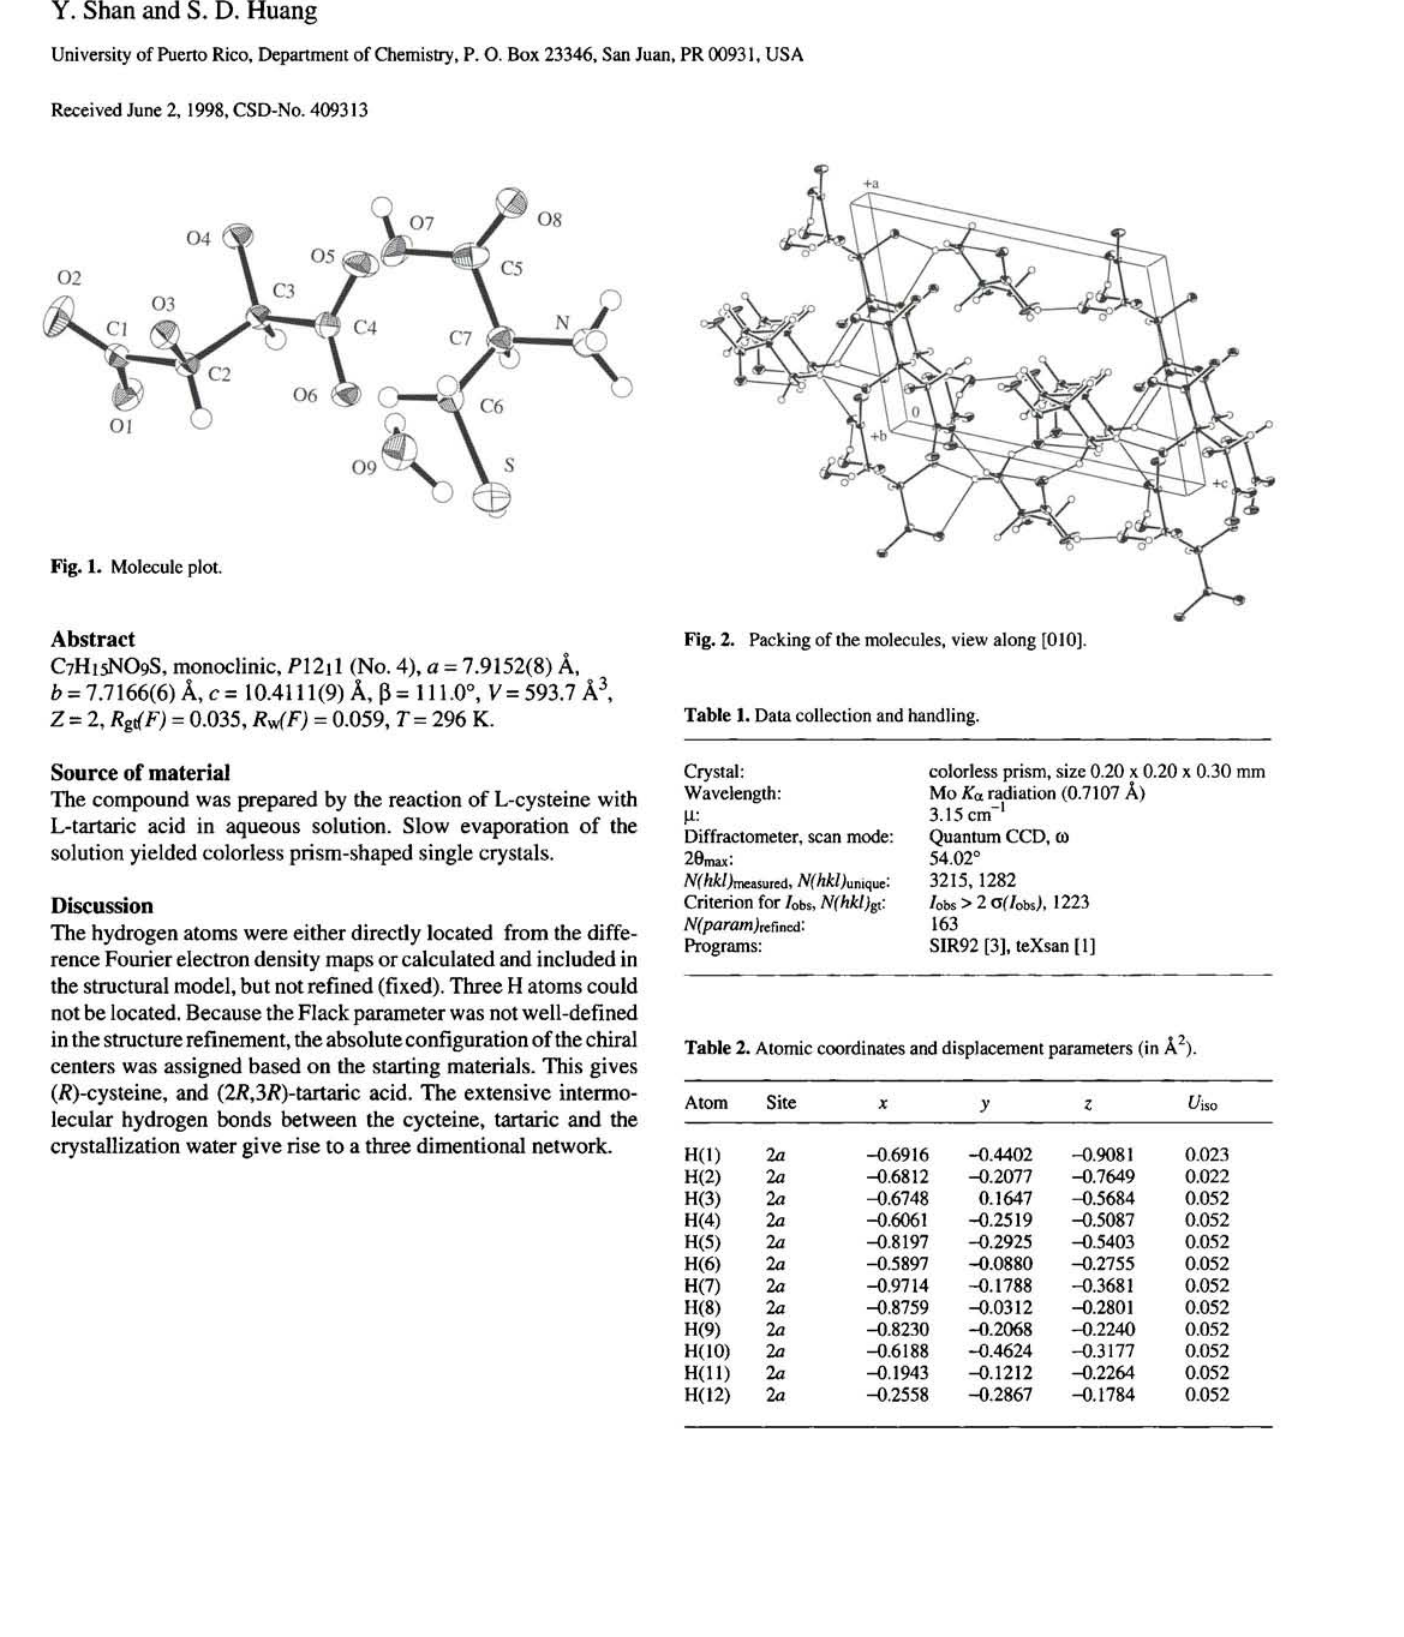
Fig. 1. Molecule plot.